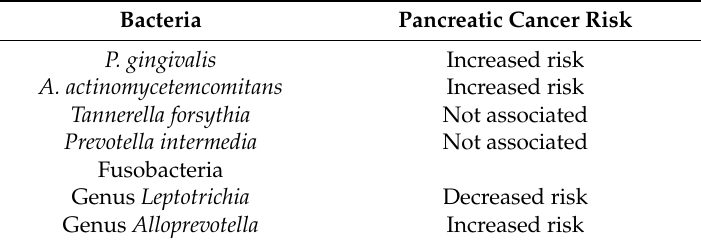
Table 1. Common oral bacteria and their associated pancreatic cancer